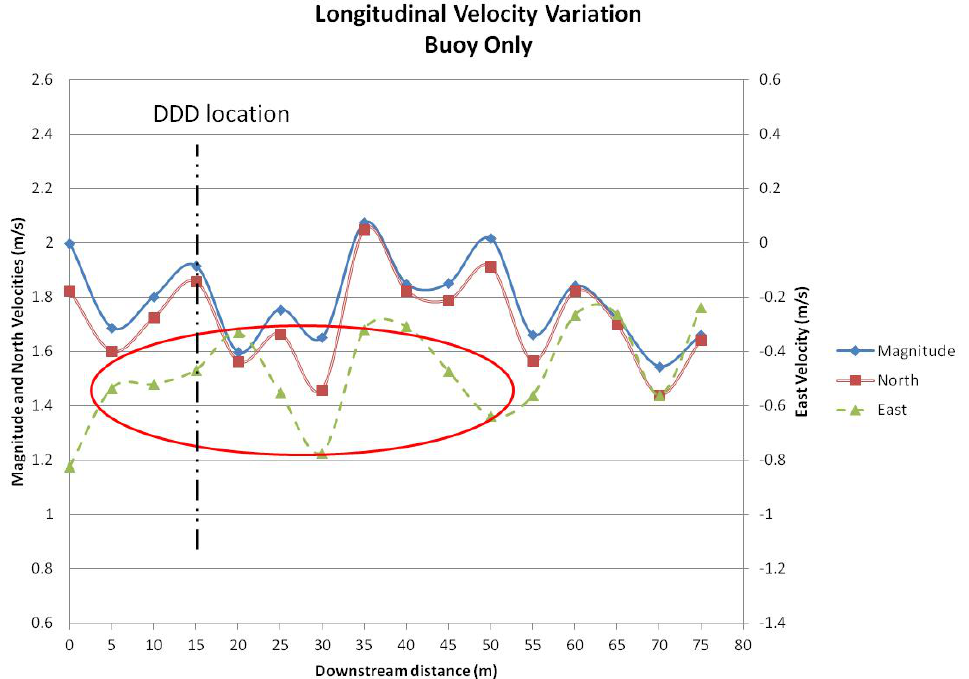
Figure 6. The main flow characteristics along the longitudinal profile. Buoy only. The red oval shows a limited velocity variation in the east